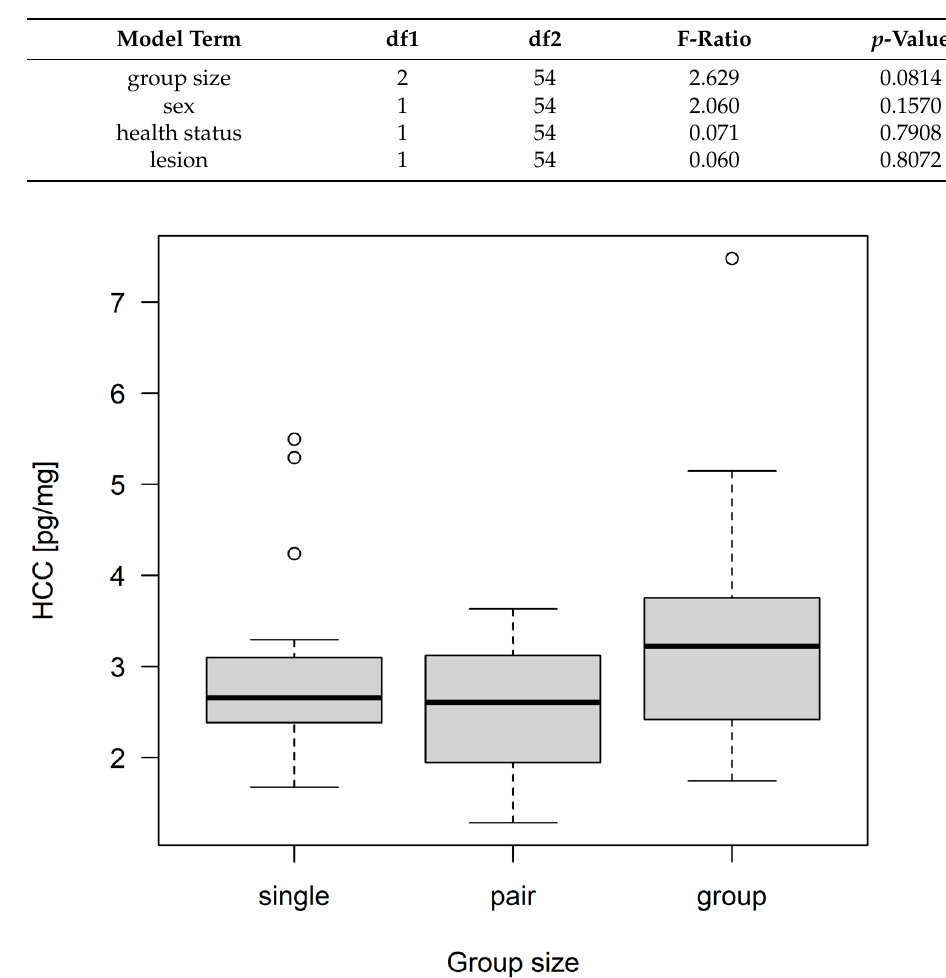
Table 6. Results of F-test for the linear regression model with HCC of kits as dependent variable.